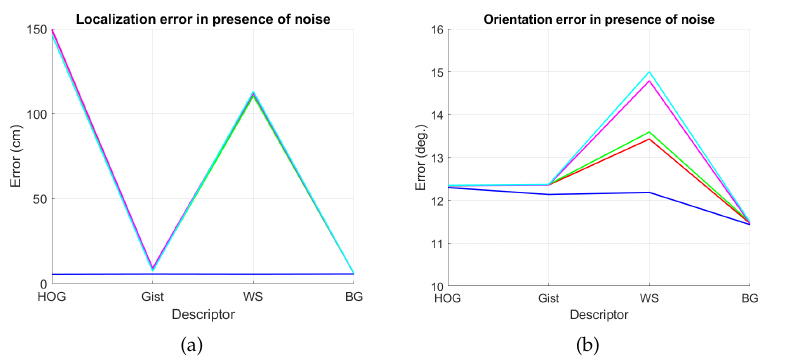
Figure 44. Average errors with the COLD dataset in the presence of noise. ( a ) Average position error (cm) and ( b ) average orientation error (deg). Legend: —– Original, —– Noise 1, —– Noise 2, —– Noise 3, —– Noise